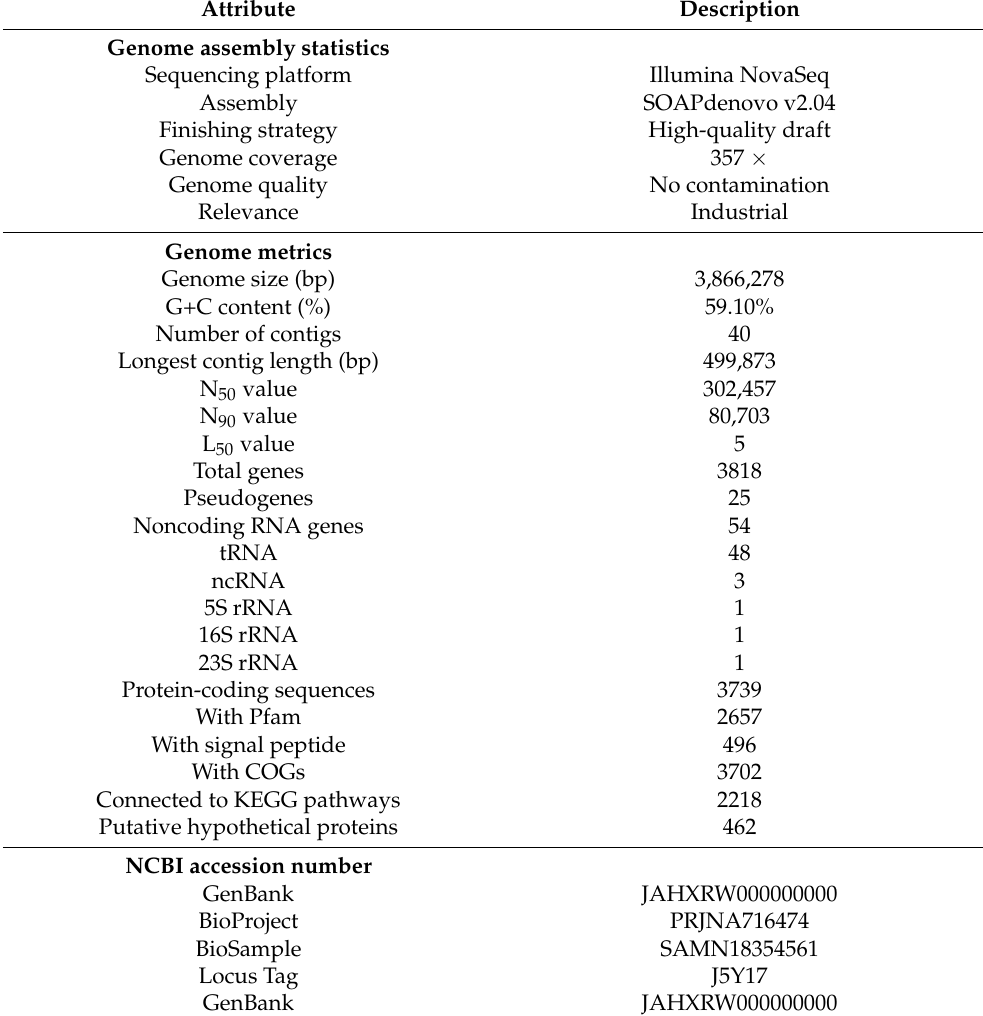
Table 2. Genome attributes of strain PS-C1 according to Minimum Information about a Genome Sequence (MIGS) specification a